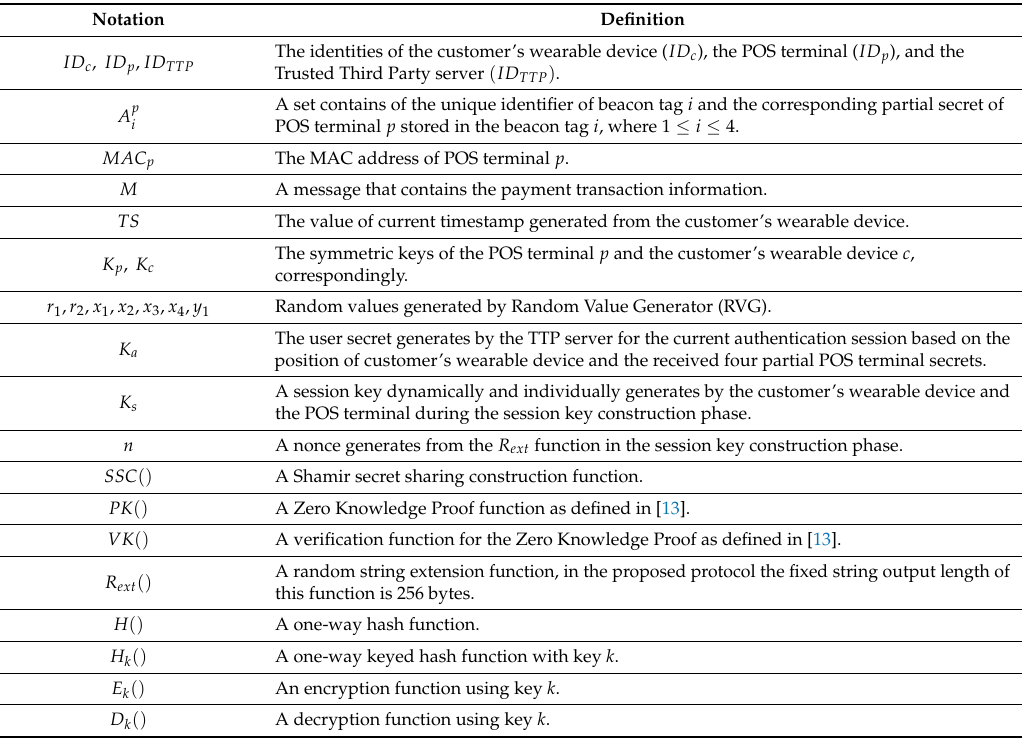
Table 1. Notations used in the proposed authentication